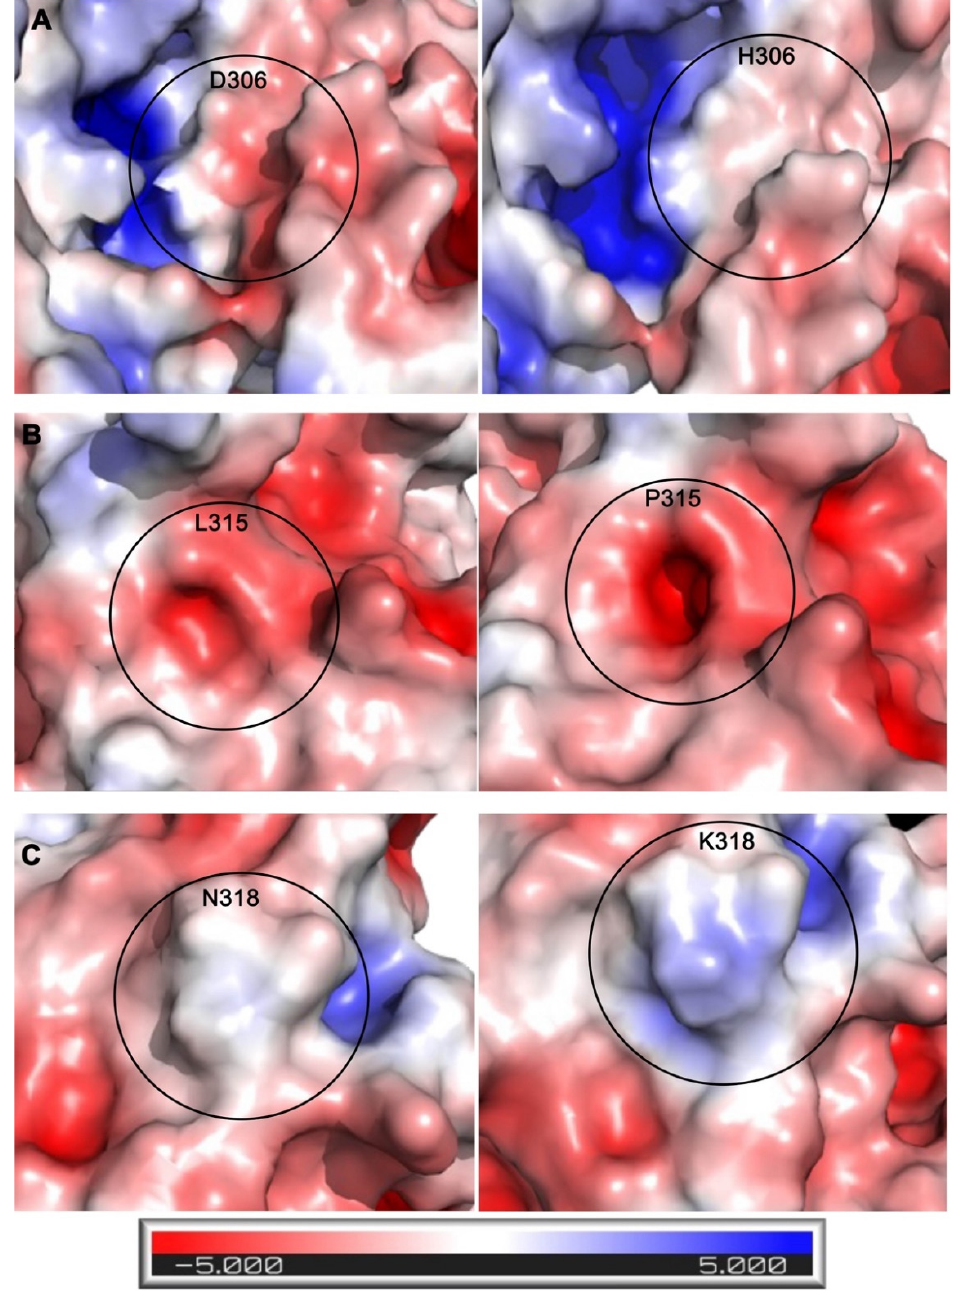
Figure 5. Electrostatic comparisons between wild-type (left panels) and mutated PRMT5 (right panels) residues. Comparisons between ( A ) D306H wild type and mutant, ( B ) L315P wild type and mutant, and ( C ) N318K wild type and mutant. Electrostatic surface potentials were calculated and displayed in PyMOL using the APBS plug-in. This is shown using a surface representation where red is a negative charge, blue is a positive charge, and white is neutral. The electrostatic scale is shown at the bottom, ranging from − 5 to +5 kT/e.